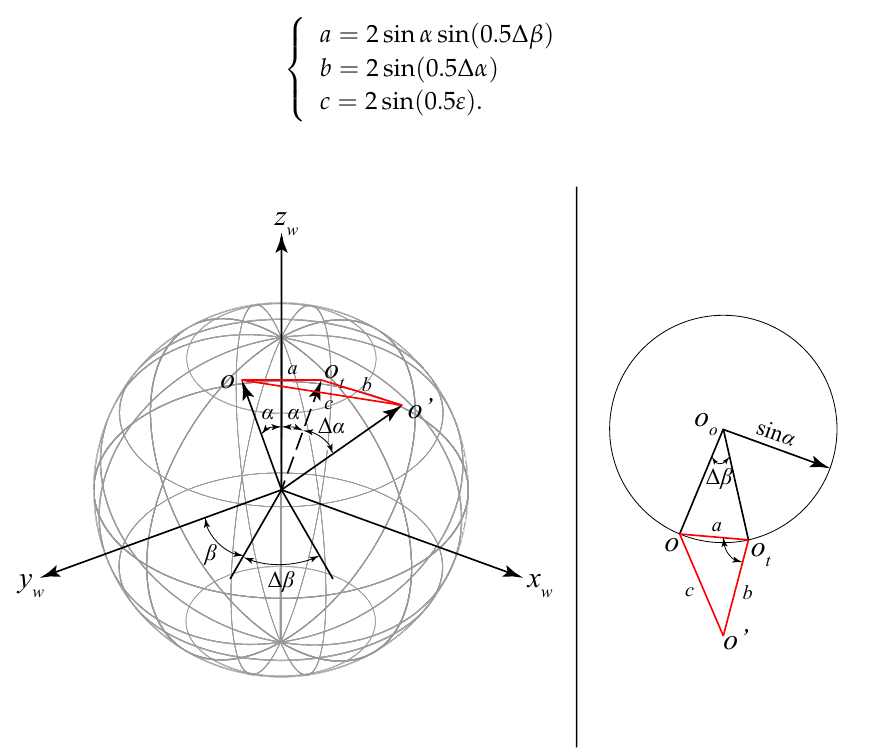
Figure 5. Fitting error and curvature of planar five-point